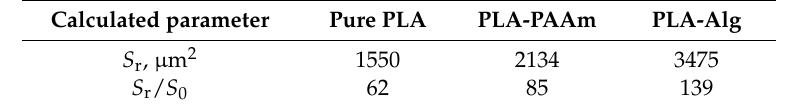
Table 2. The results of S r /S 0 parameter calculations for the initial and modified films *. Calculated